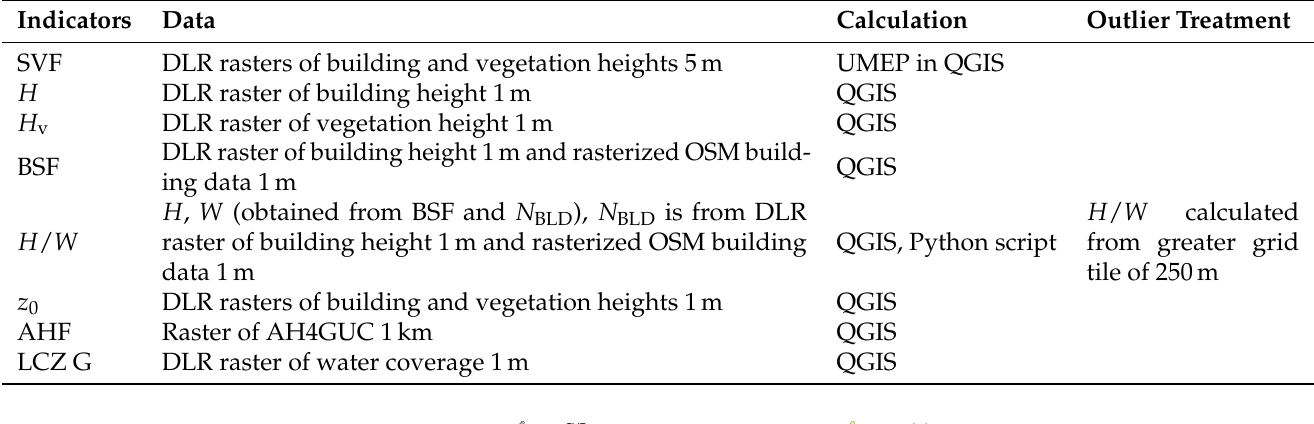
Table 1. Data sources and calculation method of zone properties and LCZ G.